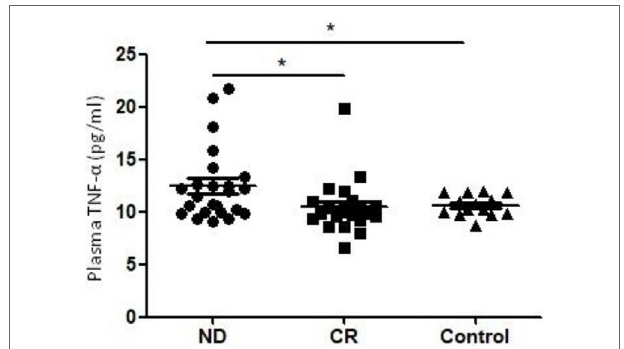
FigUre 1 | Plasma levels of tumor necrosis factor (TNF)- α in newly diagnosed (ND) acute myeloid leukemia (AML) patients, complete remission (CR) AML patients, and healthy controls. A significantly higher TNF- α level was observed in ND AML patients than in controls or CR patients (* P <